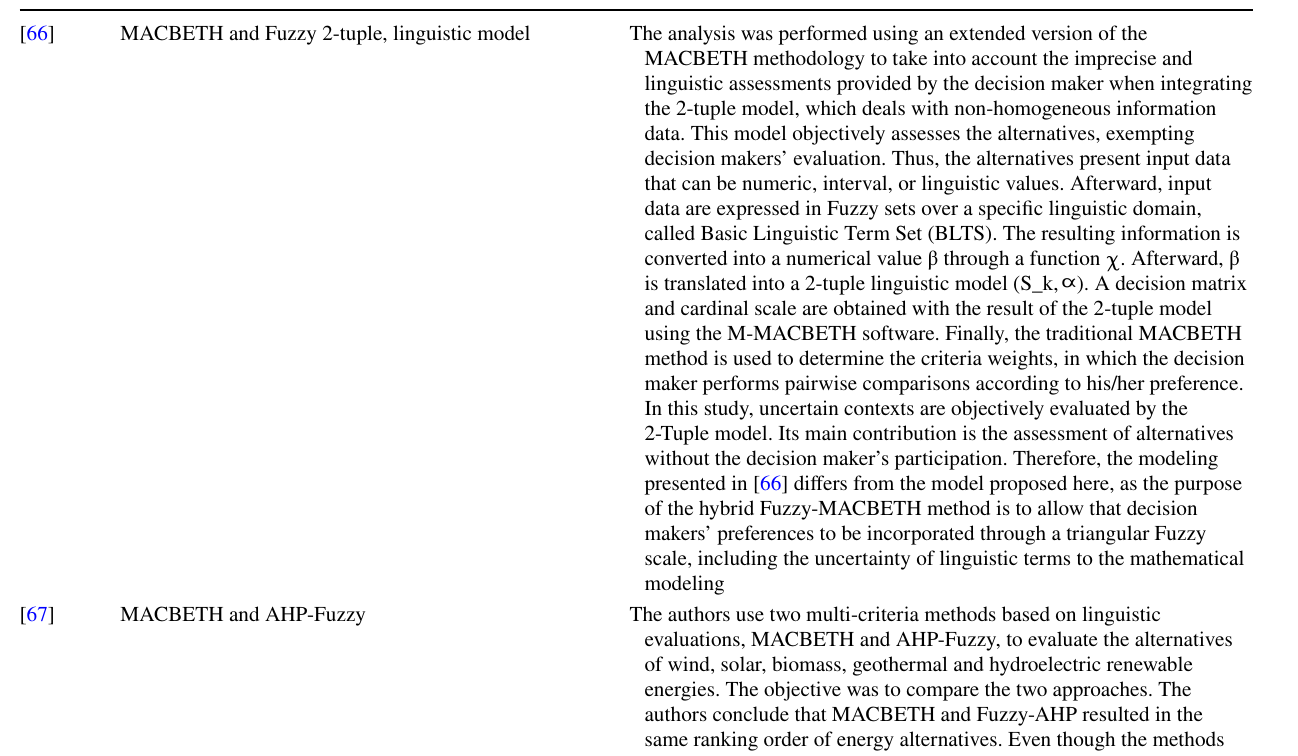
Table 2 Synthesis of studies presenting Fuzzy-MACBETH Reference Method Approach [66] MACBETH and Fuzzy 2-tuple, linguistic